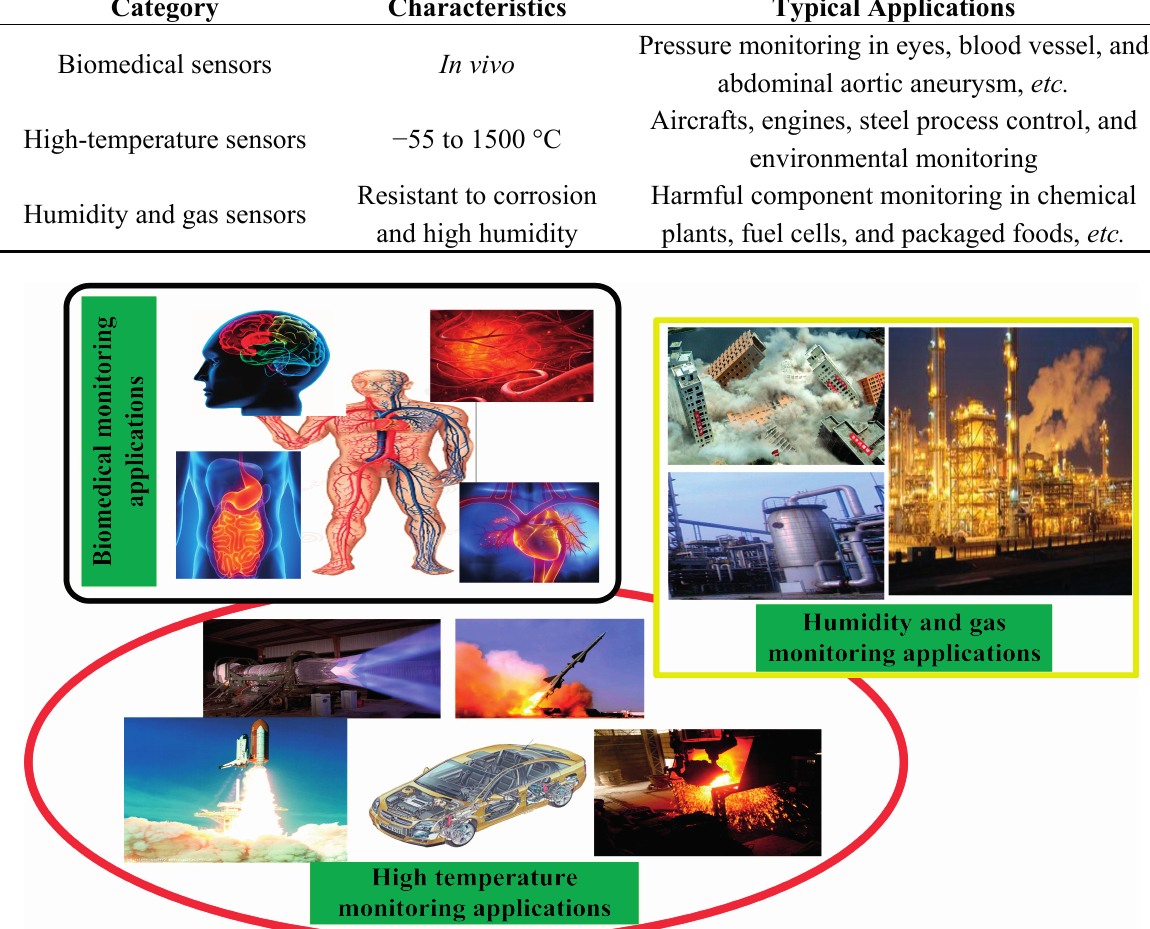
Table 1. Sensor types, sensor characteristics, and harsh-environment applications.